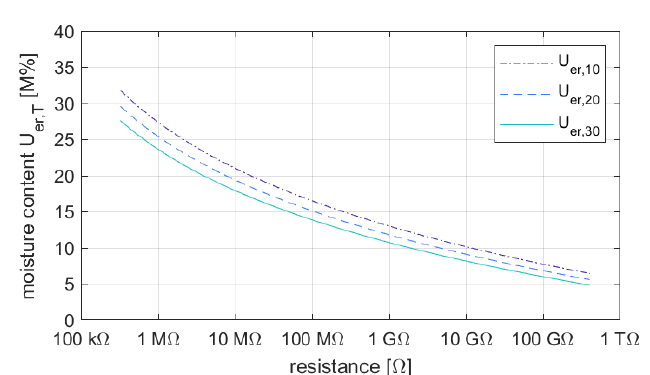
Figure 6. Relationship between resistance and moisture content for Norway spruce at different temperatures [29].